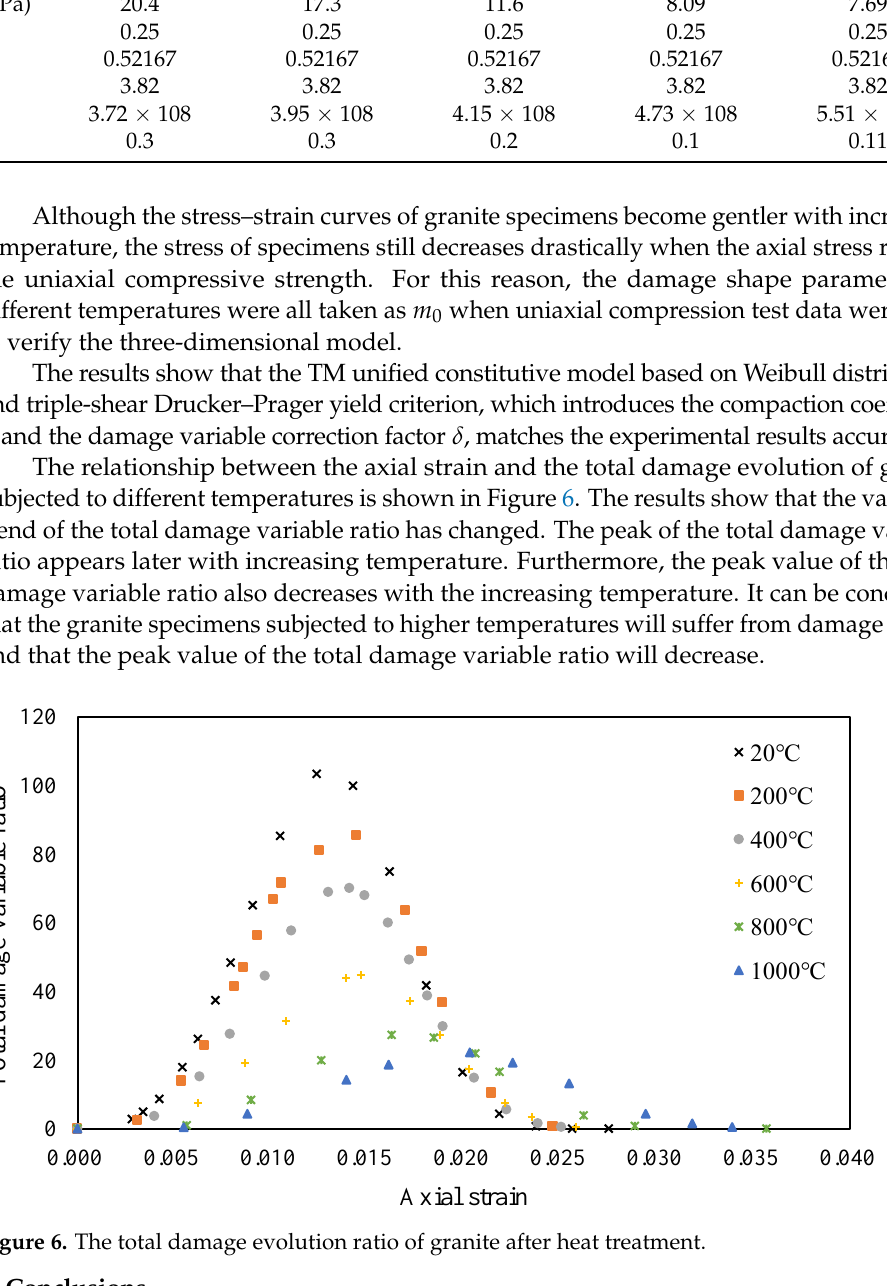
Figure 6. The total damage evolution ratio of granite after heat treatment.